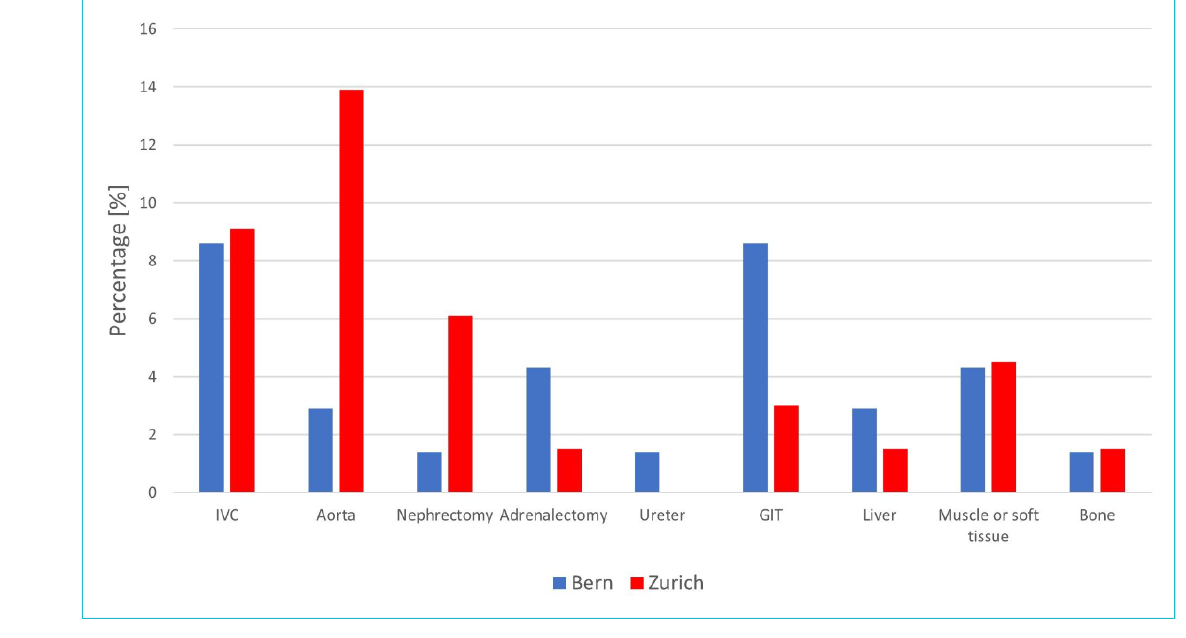
Figure 1: Additional procedures during post-chemotherapy retroperitoneal lymph node dissection by centre (IVC: inferior vena cava; GIT: gas- trointestinal